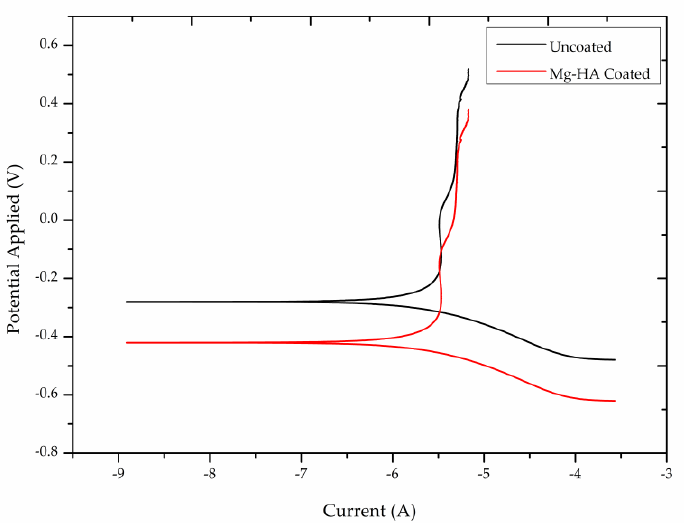
Figure 11. Potentiodynamic polarization curve of uncoated and Mg-HA coated substrates.